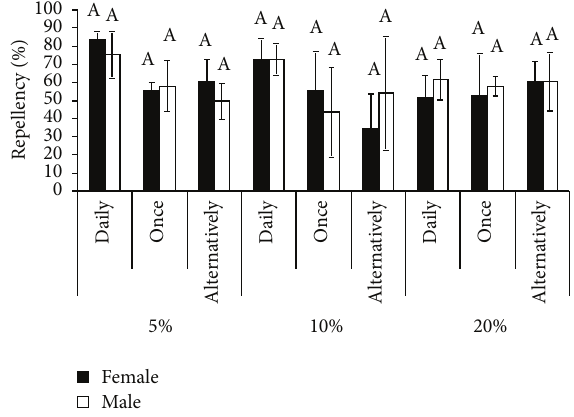
Figure 1: No significant difference in average percent repellency of eucalyptus oil in Rattus rattus between male and female rats at three different concentrations with three different modes of application each. Bars with similar superscripts differ